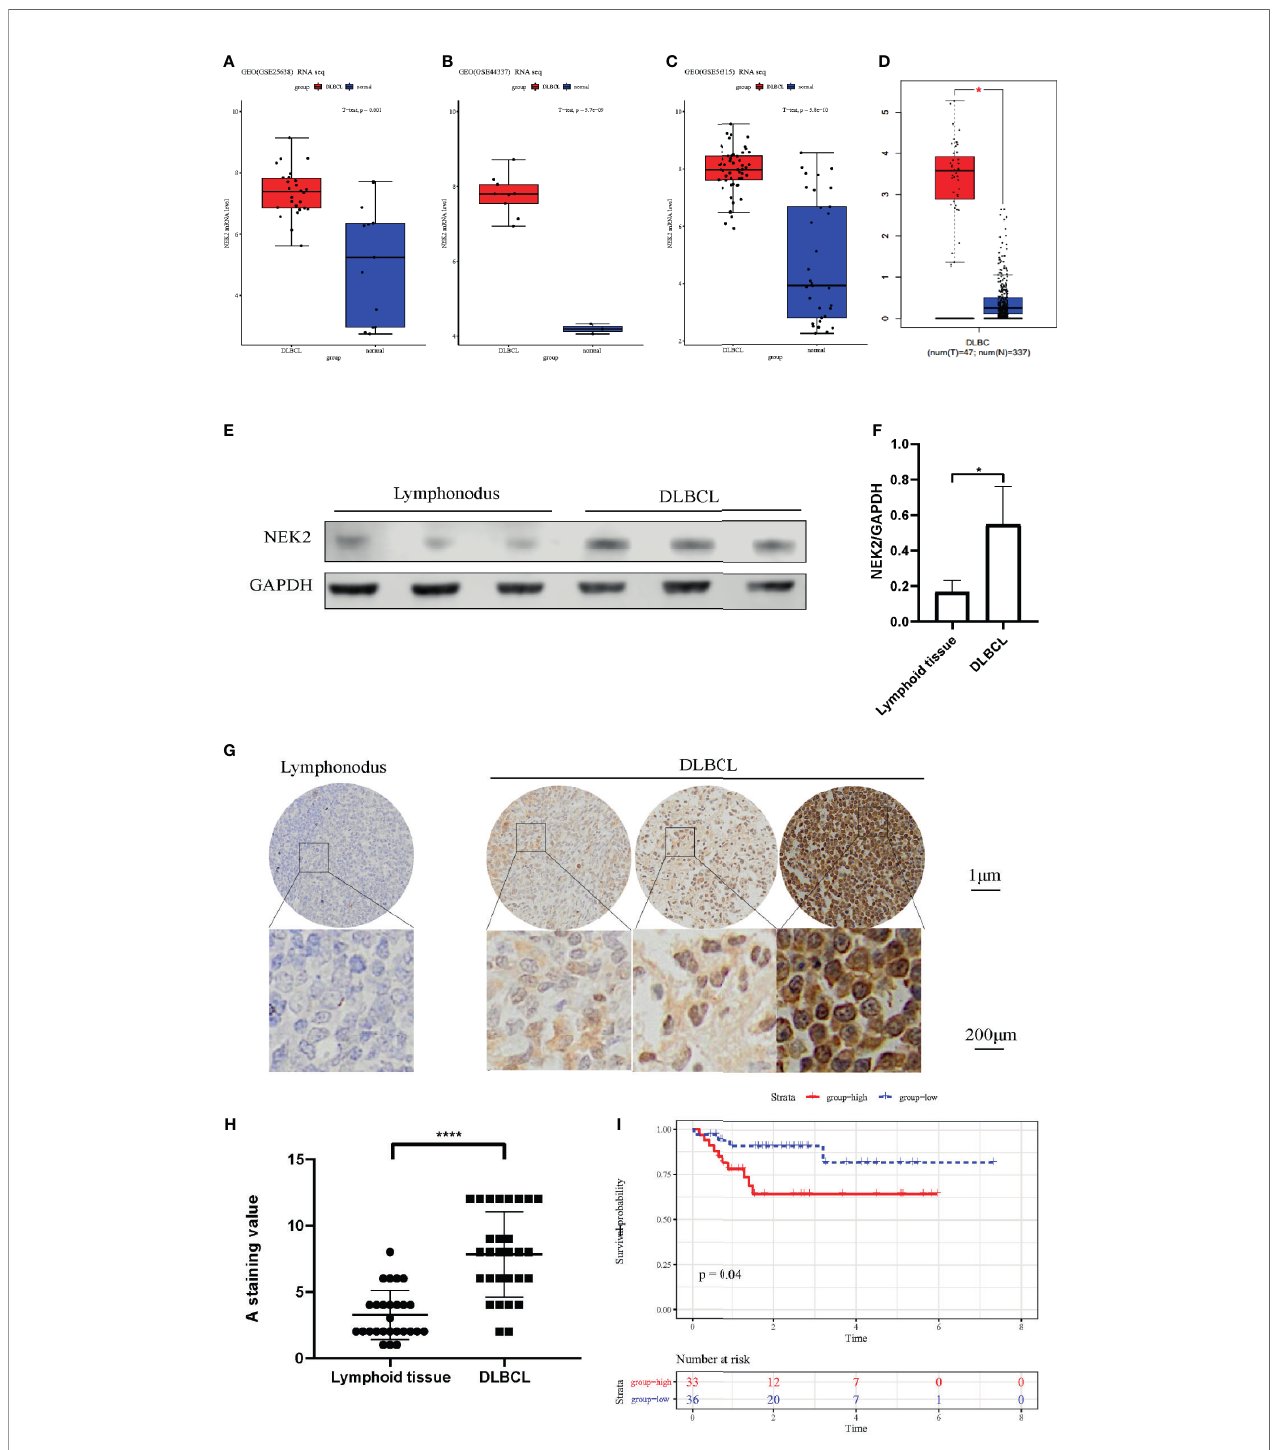
FIGURE 1 | NEK2 is highly expressed in DLBCL and indicates a poor prognosis. (A – D) Box plots for the expression level of NEK2 in GSE25638, GSE44337, GSE56315, and GEPIA; (E) NEK2 protein expression level of three lymph node samples and three patients with DLBCL; (F) Bar graph of NEK2/GAPDH relative ratio in lymph node samples and patients with DLBCL (*P < 0.05, Student ’ s t-test); (G) The expression of NEK2 was characterized by immunohistochemistry (IHC) analysis. IHC was performed using formalin- fi xed paraf fi n-embedded samples from 26 lymphoid tissues and 28 DLBCL patients. Staining intensity was graded as presented: negative, weak, moderate, and strong; (H) Grouped scatter plots of IHC score of lymphoid tissues and DLBCL specimen (****P < 0.0001, Student ’ s t- test); (I) Kaplan-Meier survival curves by survival analysis of NEK2 in